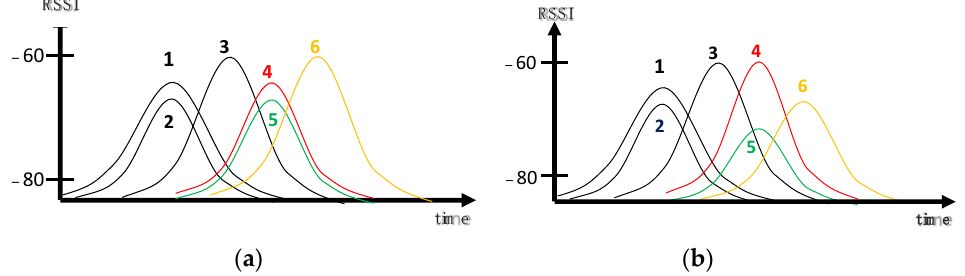
Figure 5. Variation of RSSI for LIP in two cases. (number 1~6 indicates the ITB no. shown in Figure 3) ( a ) Driving without changing lane. ( b ) Driving and changing lane.